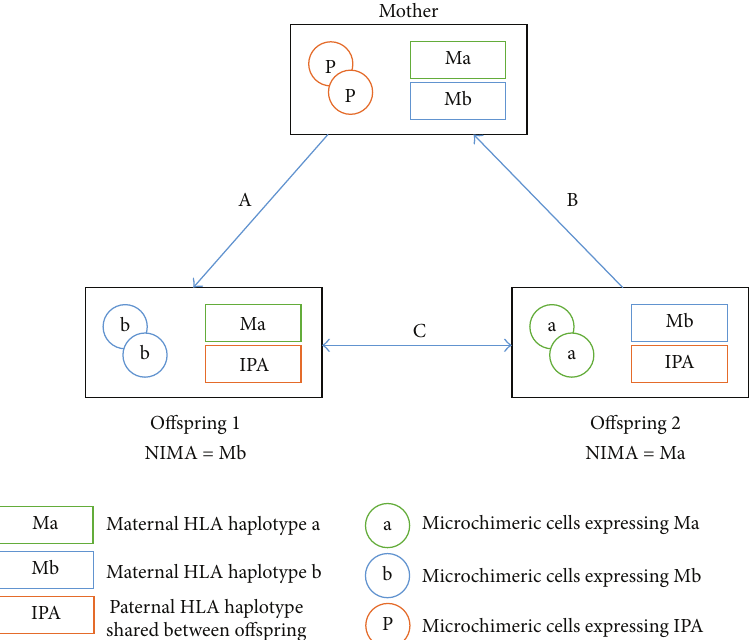
Figure 2: Illustration of three types of NIMA-complementary HLA haploidentical stem cell transplants: A, B, and C. Transplantation from mother to offspring (A) causes a graft versus host (GVH) reaction against the inherited paternal antigen (IPA) and a host versus graft (HVG) reaction against the NIMA of offspring 1 (Mb). Transplantation from offspring to mother (B) causes a GVH reaction against the NIMA of offspring 2 (Ma) and HVG reaction against the inherited paternal antigen (IPA). Transplantation between NIMA-mismatched siblings with a shared IPA (C) involves bidirectional mismatch for the NIMA and bidirectional GVH/HVG reactions. Adapted from Ichinohe et al.